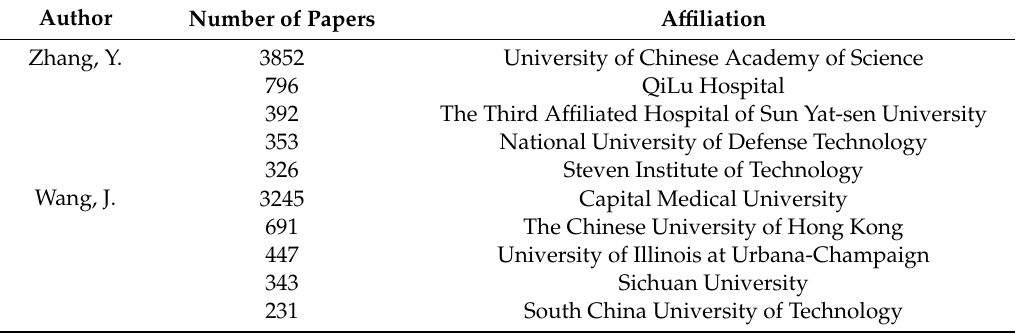
Table 3. Statistical data on the number of papers published by authors from di ff erent a ffi liations with the same abbreviated